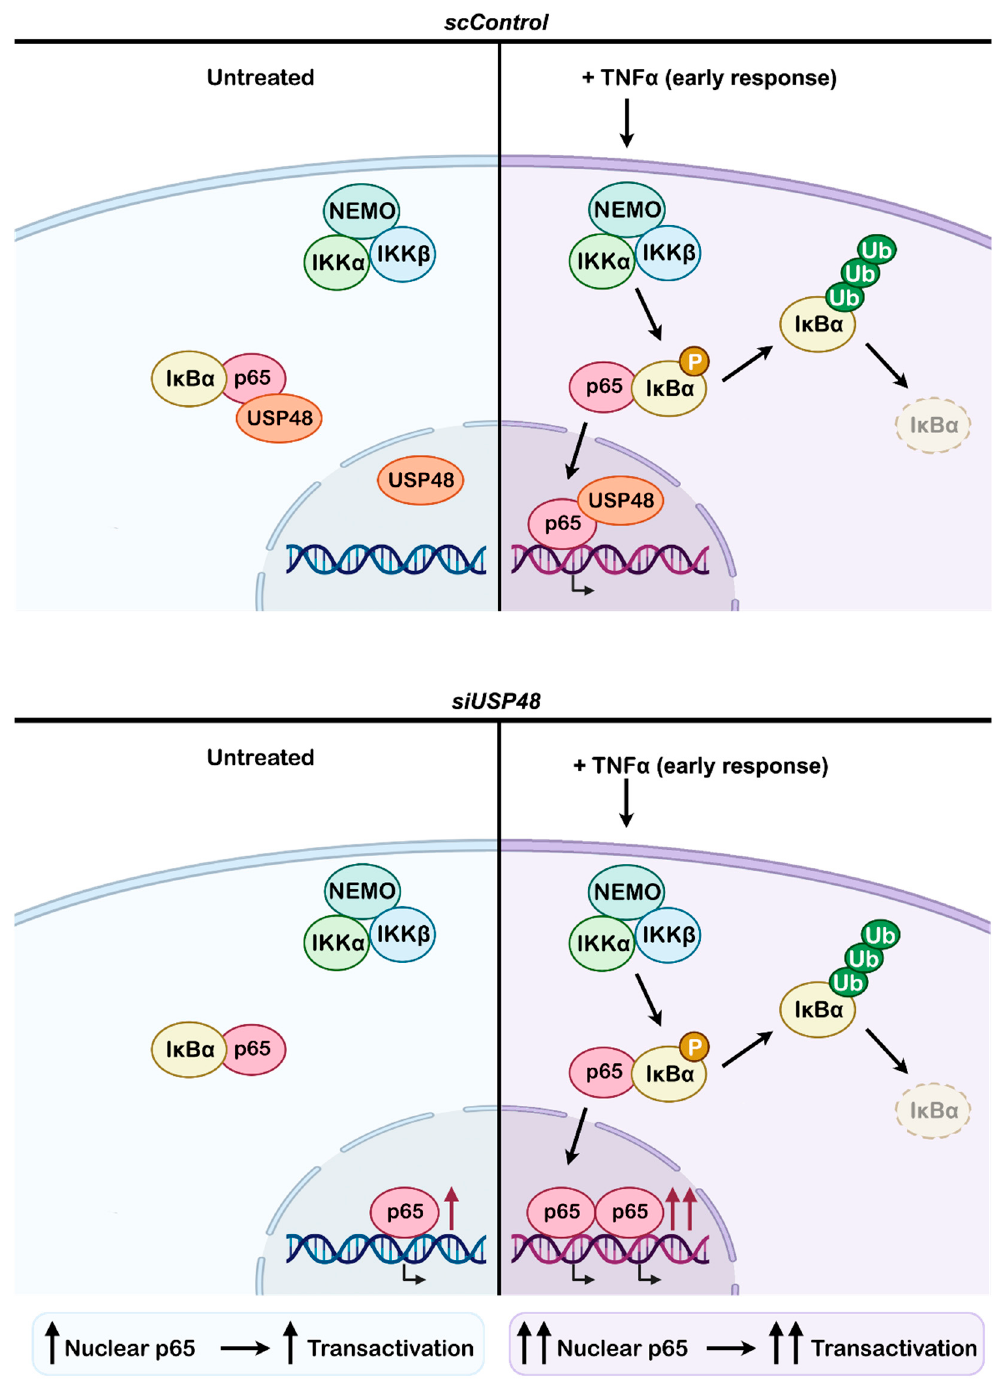
Figure 6. USP48 downregulation induces the activation of the NF- κ B pathway. In control (scControl) untreated conditions, p65 is sequestered in the cytoplasm by I κ B α . Upon TNF α stimulation, I κ B α is phosphorylated by the IKK α :IKK β :NEMO complex, resulting in I κ B α ubiquitination and subsequent proteasomal degradation. As a consequence, the liberated p65 translocates to the nucleus, where it activates the transcription of target genes and can interact with USP48. When USP48 is downregulated (siUSP48), p65 levels increase –mainly in the nucleus– inducing the transcriptional activation of NF- κ B target genes, even without TNF α stimulation. The levels of p65 further increase in the nucleus upon TNF α treatment, in an additive response, thus resulting in further transactivation of target